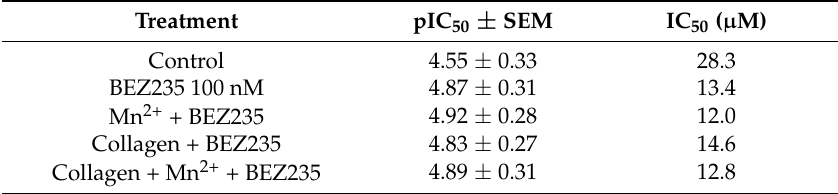
Table 2. IC 50 of cisplatin cytotoxicity on MV3 cells treated with 100 nM BEZ235.